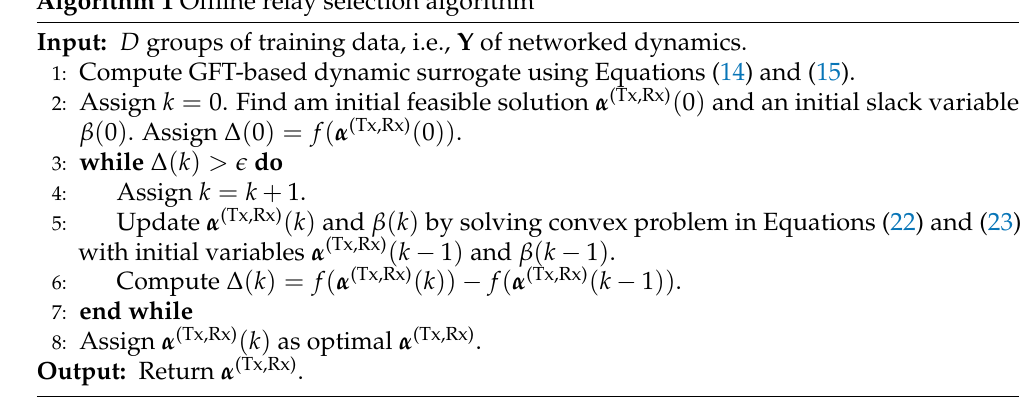
Algorithm 1 Offline relay selection